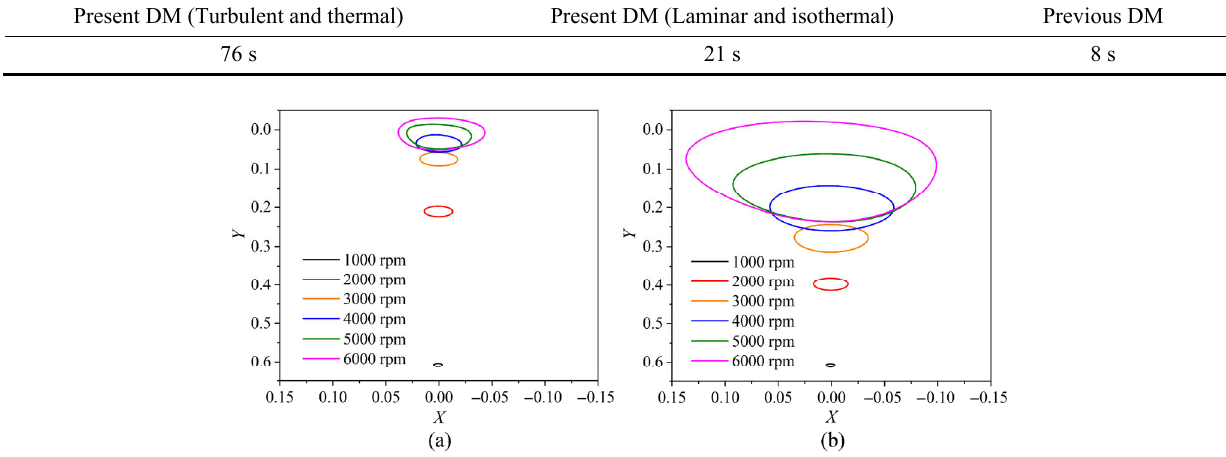
Fig. 7 Journal center orbits (a) with and (b) without turbulent and thermal